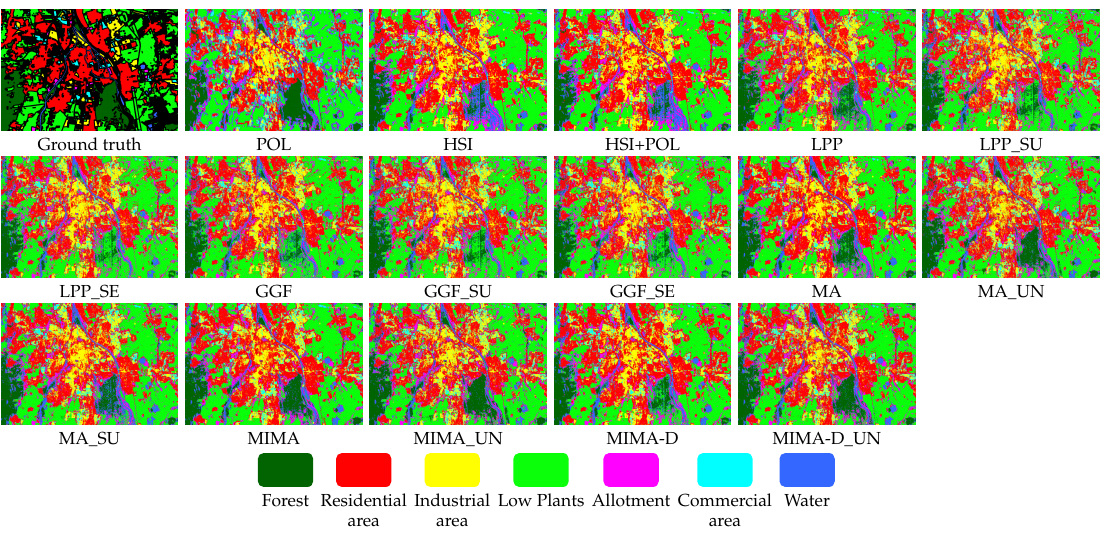
Figure 7. Visualization of the achieved classification maps and the ground truth. The 16 classification maps are provided by applying CCF on fused data of the 16 algorithms, for the Augsburg data set. Classification maps achieved by manifold alignment fusion methods are more accurate than the maps achieved by data alignment fusion methods, especially MIMA based